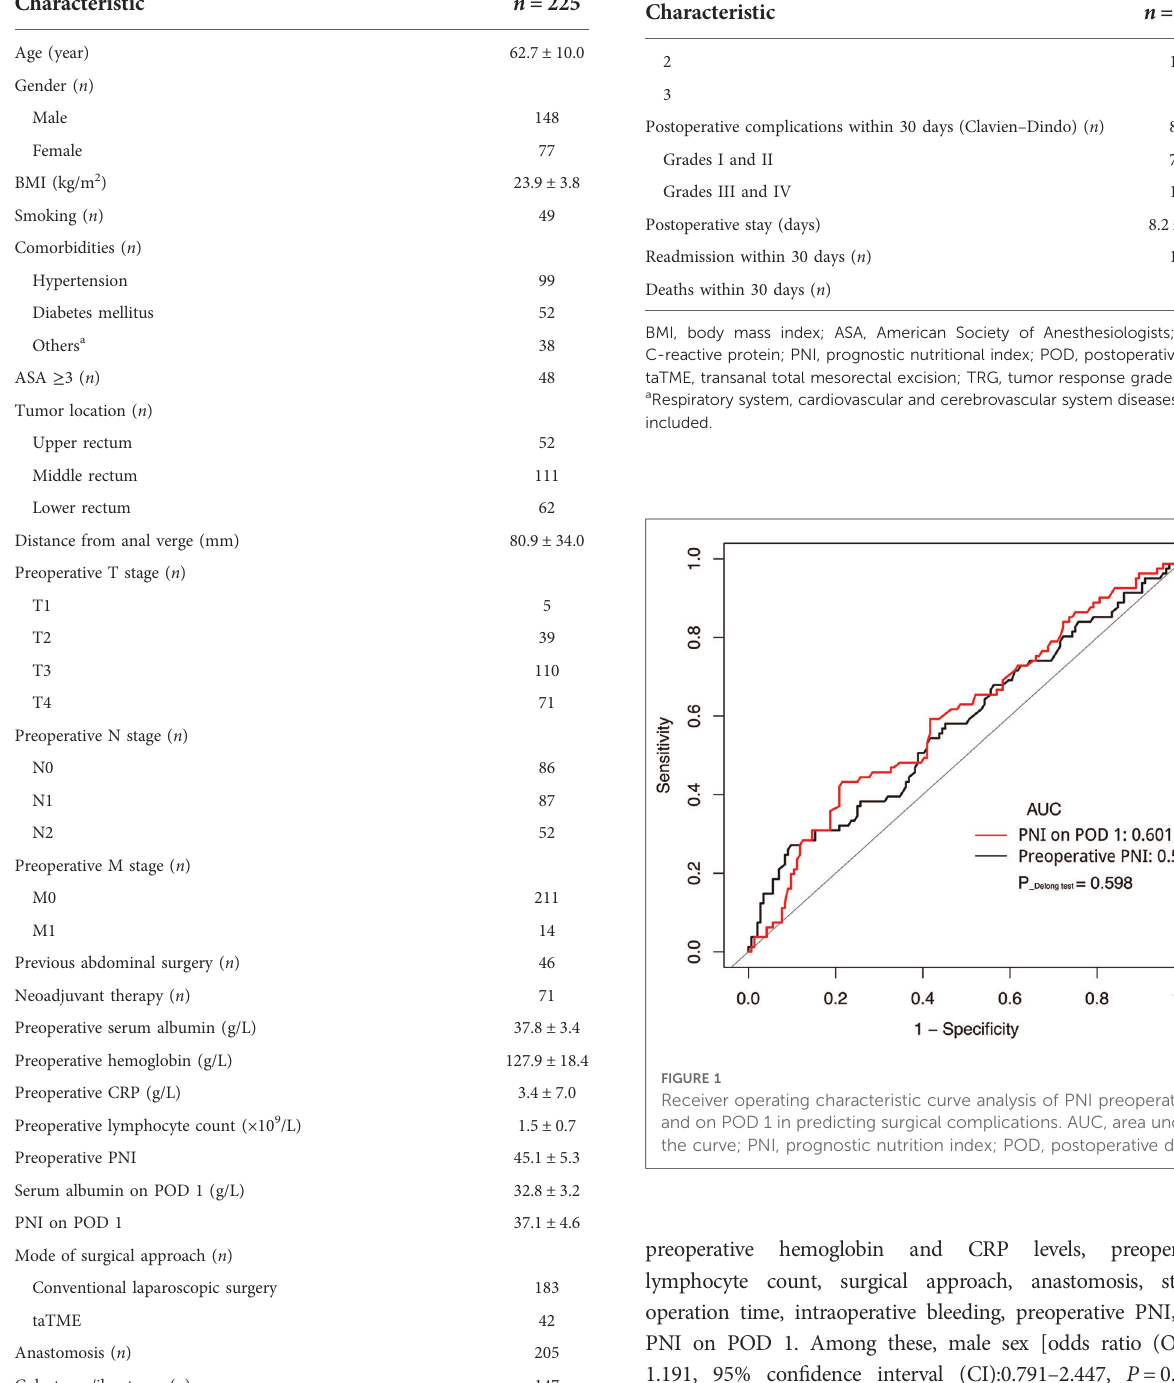
TABLE 1 Demographic and clinical features of patients.